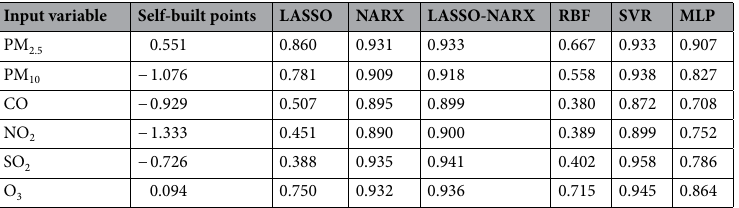
Table 4. R 2 of six types of air pollutant concentrations between self-built points, model forecast values and national control point.